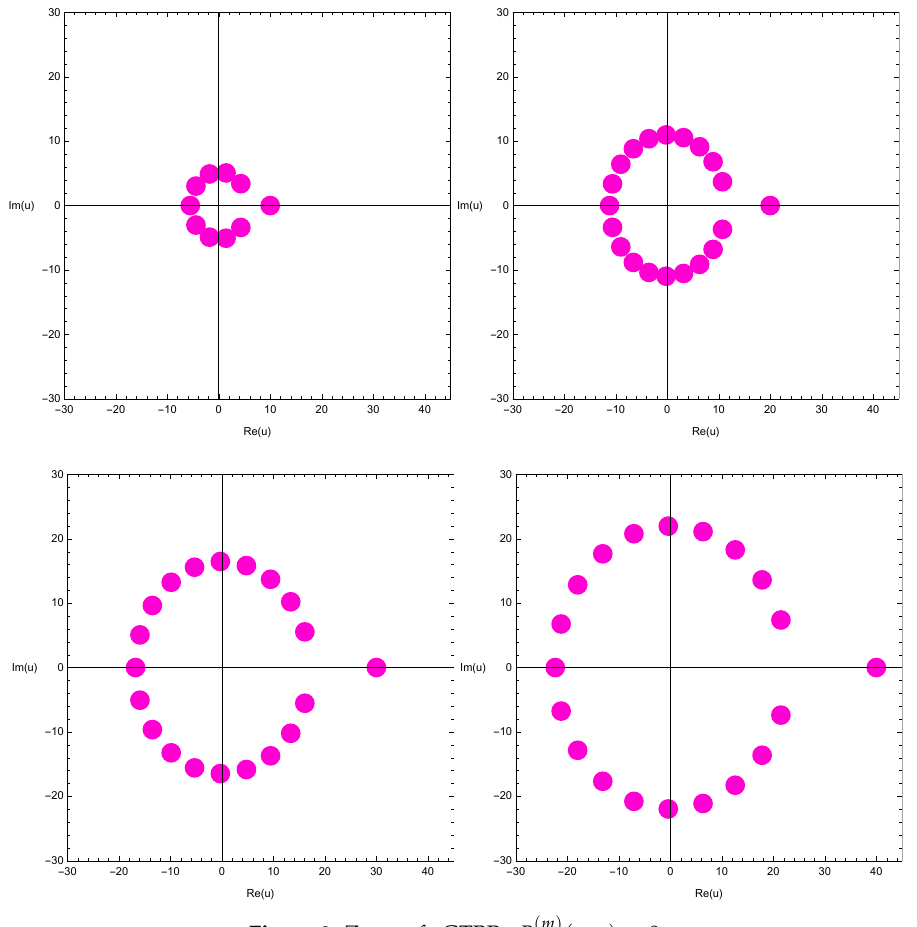
Figure 2. Zeros of q GTBP C B